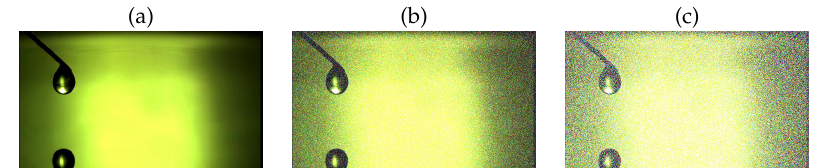
Figure 15. Example frames showing visual effect of Gaussian noise as parameters increase. ( a ) Noise level 0; ( b ) Noise level 50; ( c ) Noise level 100.